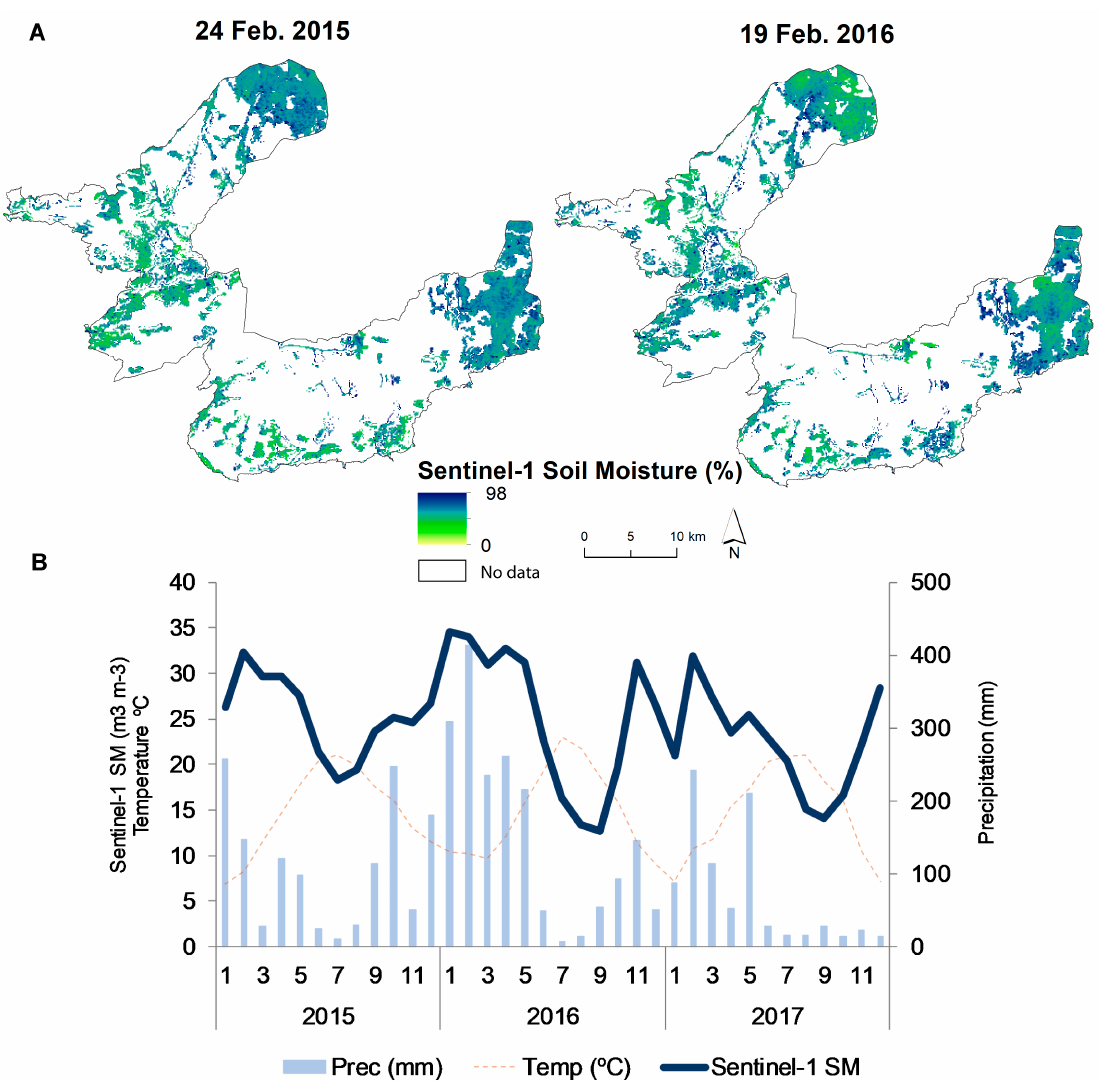
Figure 4. Sentinel-1 soil moisture (%) in PGNP. ( A ) Spatial distribution of soil moisture in two dates of the month of February 2015 and 2016, respectively. Cells with no data (white) refer to cells that the algorithm does not retrieve, such as forest and bare rock land cover classes. ( B ) Average monthly Sentinel-1 soil moisture for the years 2015, 2016, and 2017 with average monthly local precipitation (mm) and temperature (°C) from SNIRH (snirh.apambiente.pt).